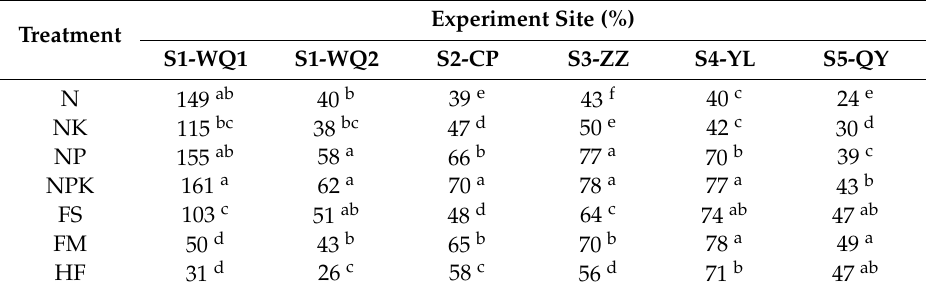
Table 2. Table 2. Average of NRE ac during 15 years at all sites. Table 2. Average of NRE ac during 15 years at all sites.